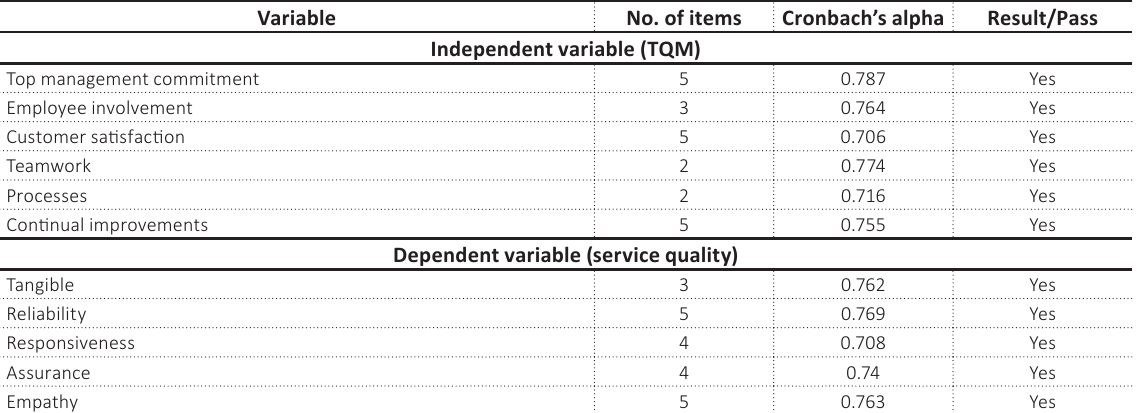
Table 3. Reliability test